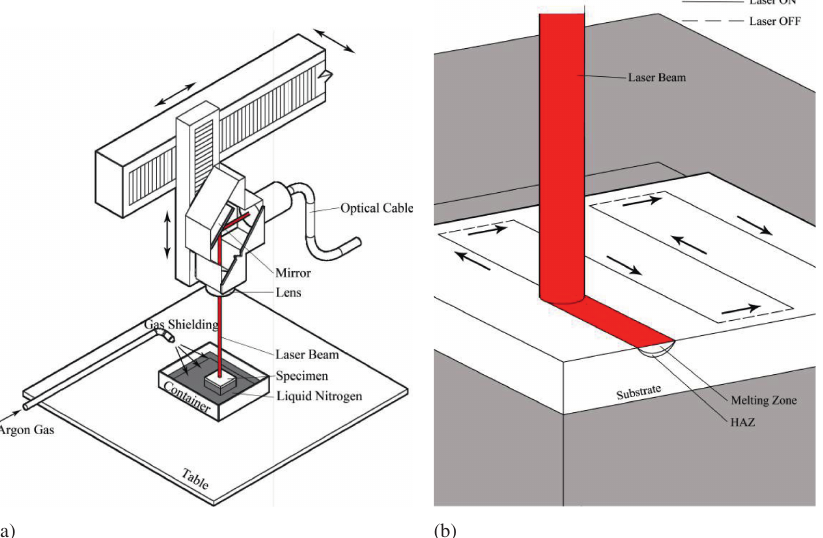
Figure 1: Schematic illustration of laser surface melting process (a) Nd-YAG laser system, (b) appearance of melted layer and laser beam scan direction.